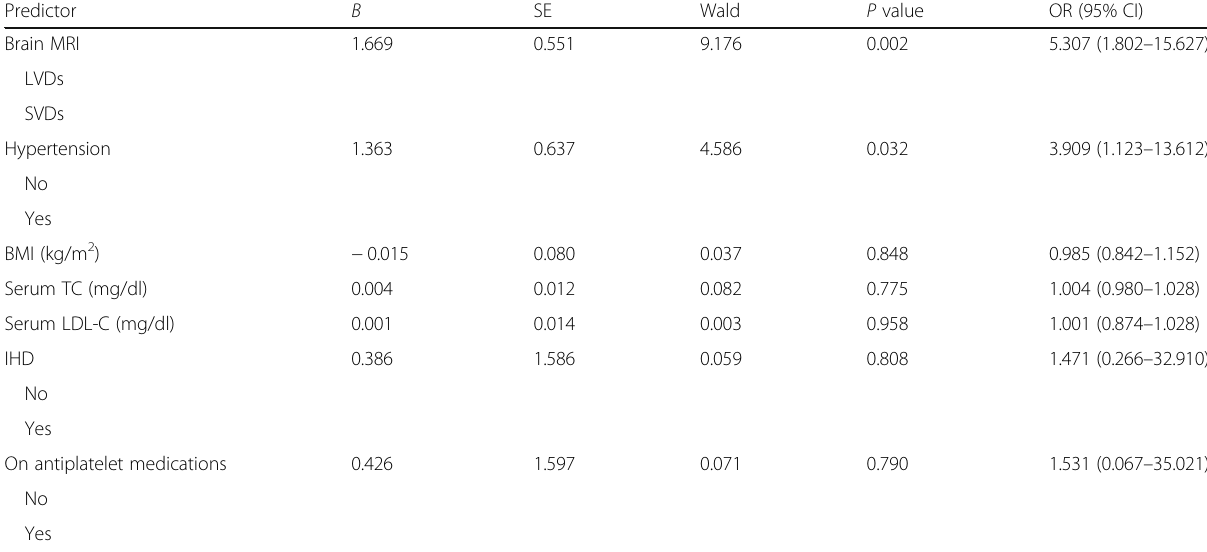
Table 4 Predictors of the likelihood of occurrence of